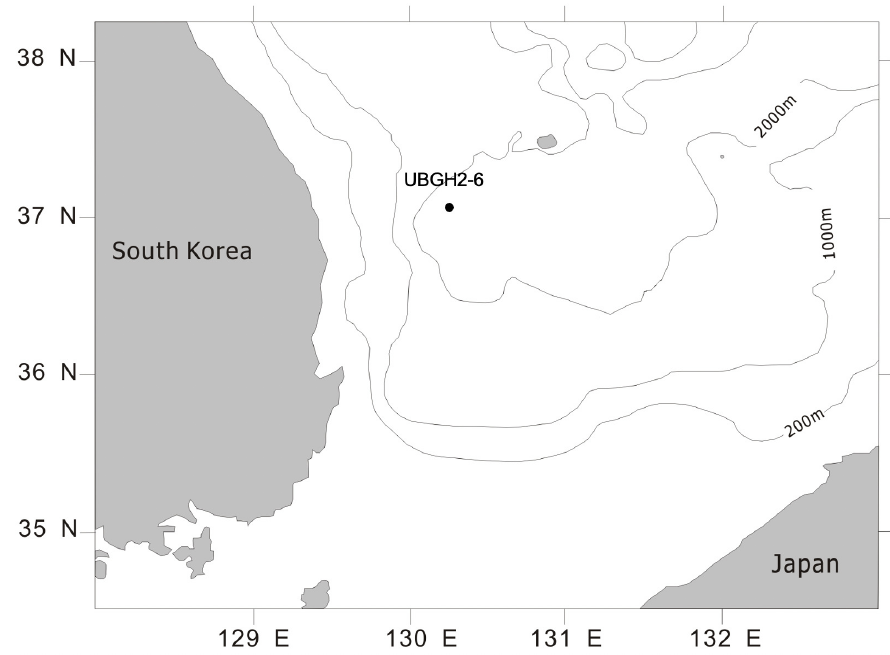
Figure 3. The UBGH2-6 site for gas hydrate reservoirs in the Ulleung Basin, East Sea, Korea